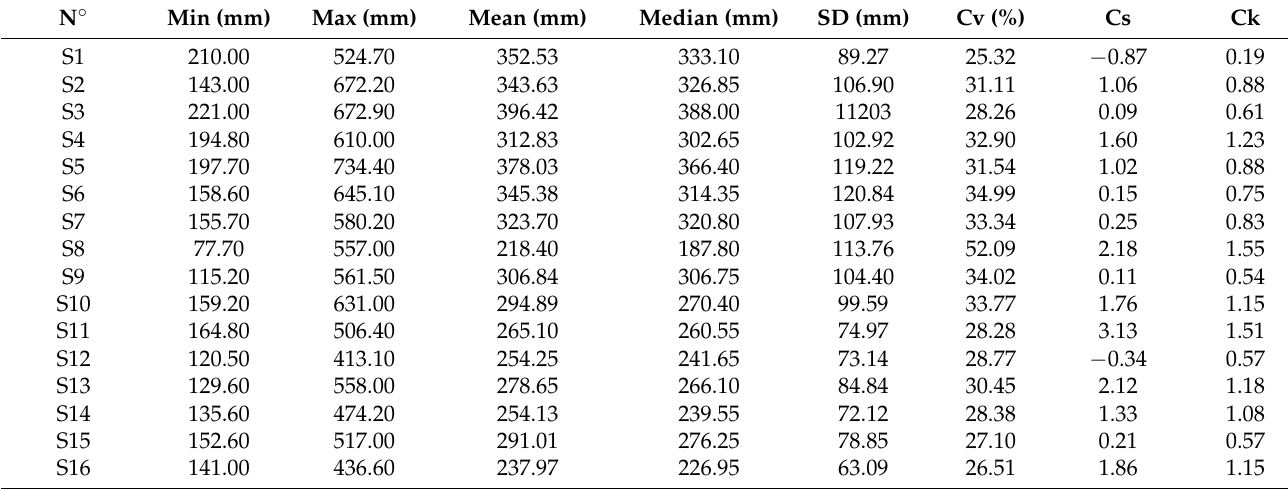
Table 2. Descriptive statistics of annual rainfall series in the Wadi Mina basin (1970/71–2009/10 water years). N